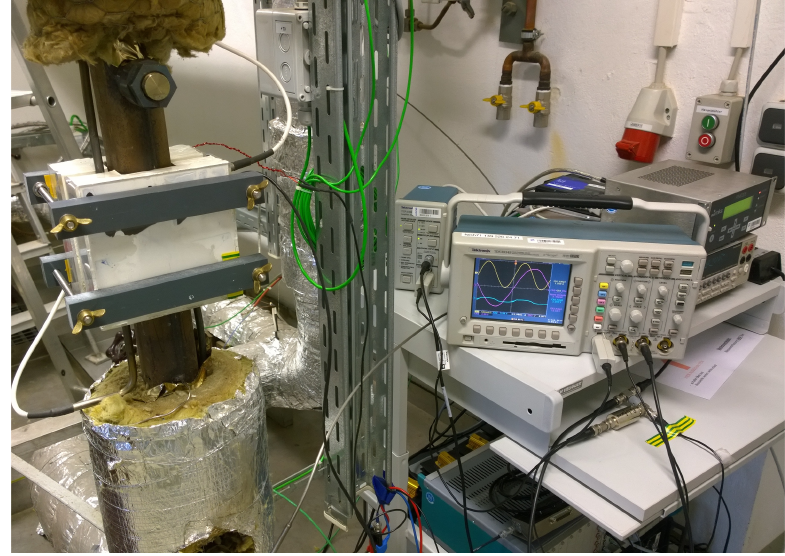
Figure 9. Installation of the sensor at the sodium loop.